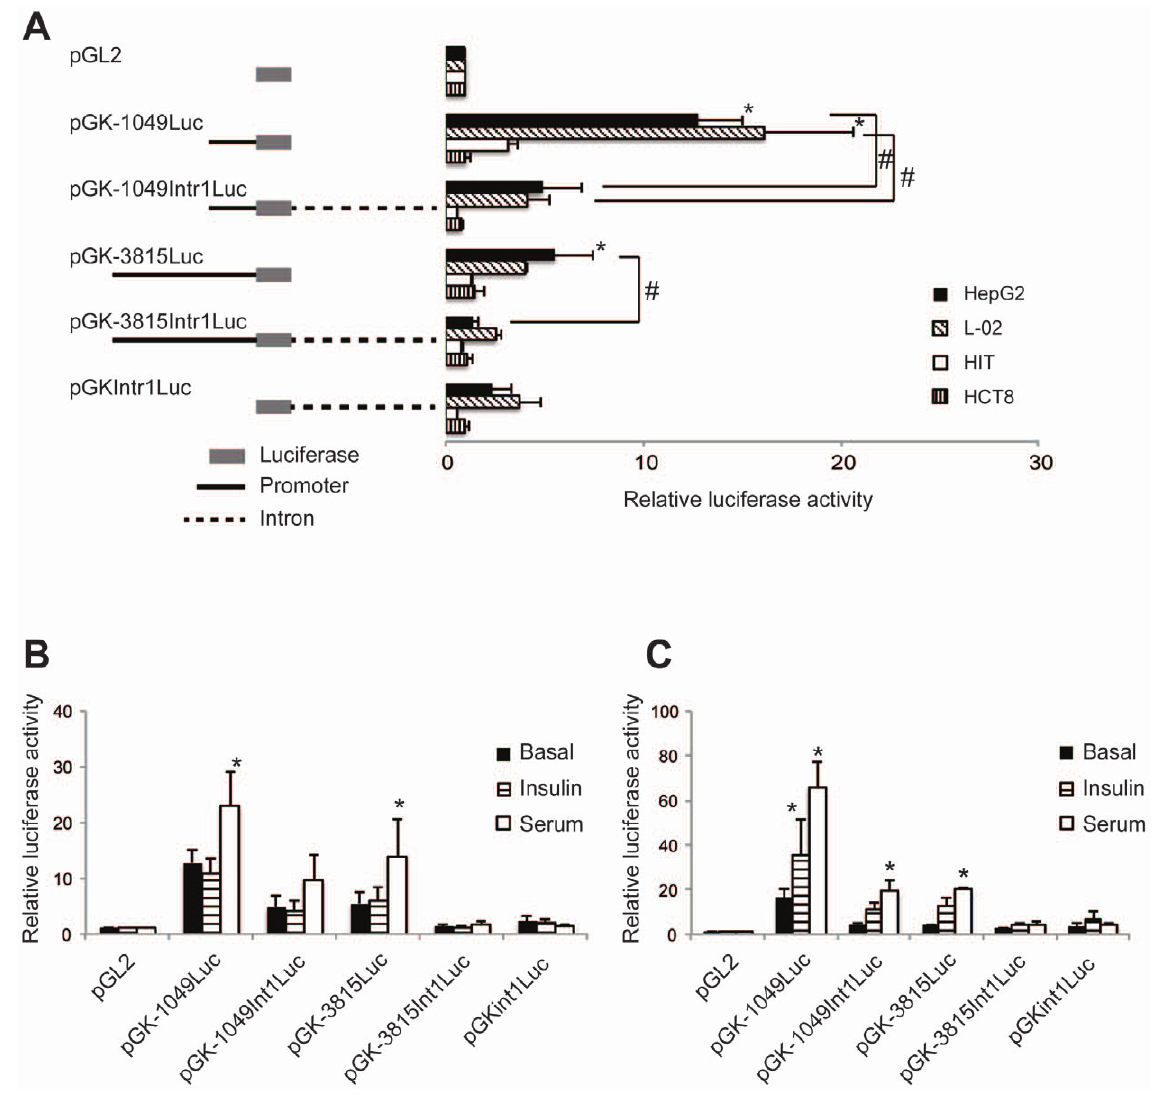
Figure 2. Intron 1 sequences regulate expression of the human glucokinase promoter. A. Schematic illustrations of reporter gene constructs with 1049 or 3815 bases of liver-specific glucokinase 5 9 flanking sequence with or without intron 1 are shown on the left. Solid boxes are the luciferase-coding regions. Thin lines represent glucokinase 5 9 flanking sequences (1049 or 3815 bases) while the broken lines represent intron 1 sequences. See Fig. S1 for the locations of genomic fragments within the gene. To the right are the luciferase reporter activities detected in two human liver cell lines (L-02 and HepG2), a hamster pancreatic beta-cell line (HIT) and a human intestinal cell line (HCT8). Data are the Mean 6 S.D. of three independent experiments. Asterisk (*) indicates reporter gene activity that is significantly greater than that from pGL2 basic. Significant differences in the activity of constructs that differed due to the presence or absence of intronic sequences are indicated by the pound symbol ( # ), with the comparison shown by the lines (P , 0.05). B and C, Responsiveness of the human glucokinase reporter constructs to insulin and fetal calf serum (serum) in HepG2 (B) and L-02 (C) cells. Basal refers to culture without insulin or serum. Constructs from part A were incubated in the presence of absence of 100 nM insulin or 10% fetal calf serum for 20 hours. Data are the Mean 6 SD of three independent experiments. Asterisk (*) indicates conditions that have significantly greater activity than the basal level for that construct (P , 0.05).